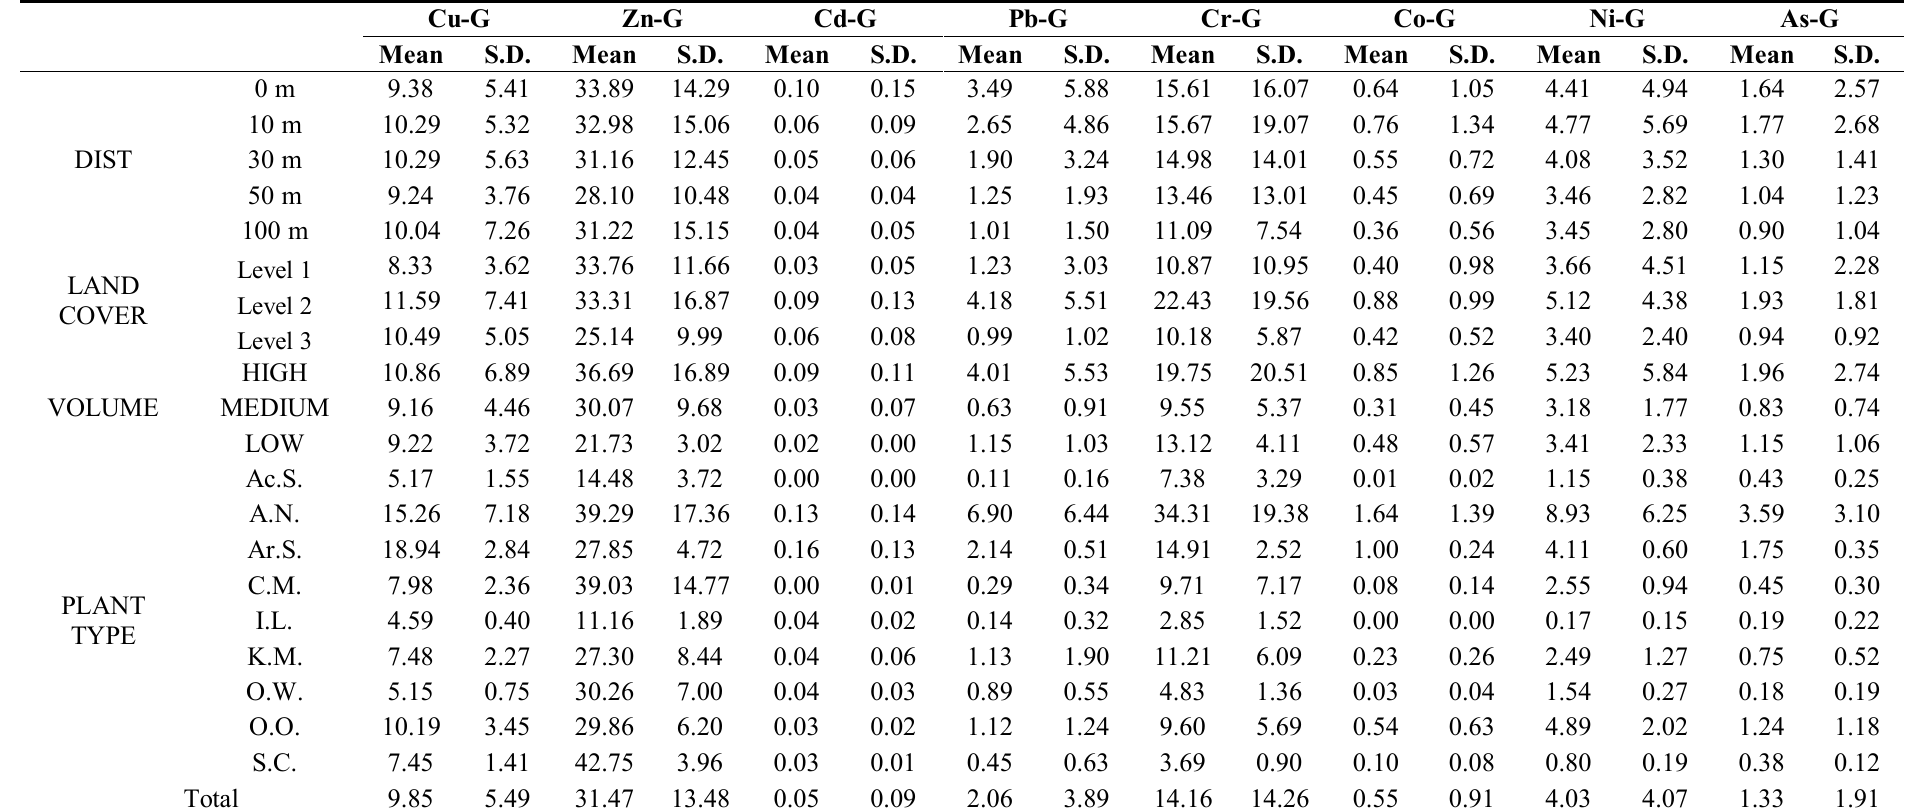
Table 5. Descriptive Statistics of Trace Element Concentrations in Grasses